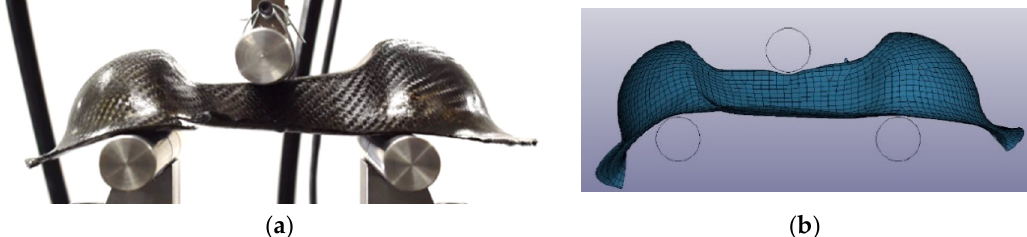
Figure 33. Experimental–FEA visual comparison during the three-point bending test on the CF/PA66 Double Dome: experimental test ( a ) and virtual simulation ( b ).